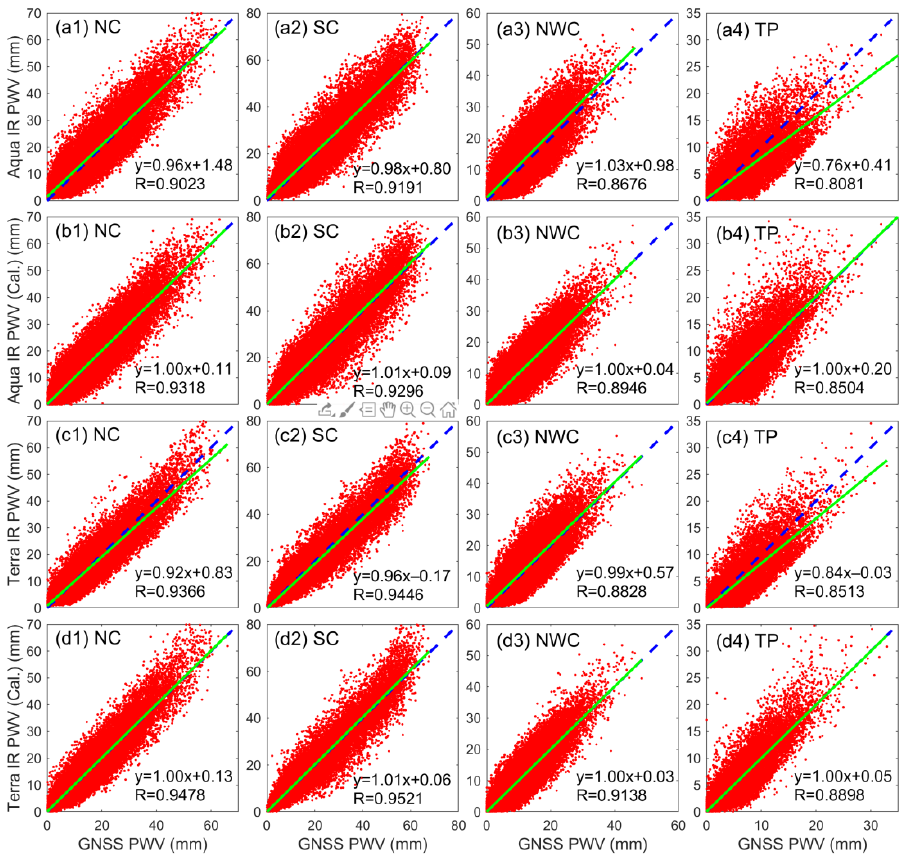
Figure 6. Scatterplots of the MODIS-derived IR PWV values with and without calibration over the period of 2011 – 2017 in the four areas in China, where ( a1 – b4 , c1 – c4 ) are the comparison of Aqua/Terra IR and GNSS PWV, and ( b1 – b4 , d1 – d4 ) are the comparison of calibrated Aqua/Terra IR and GNSS